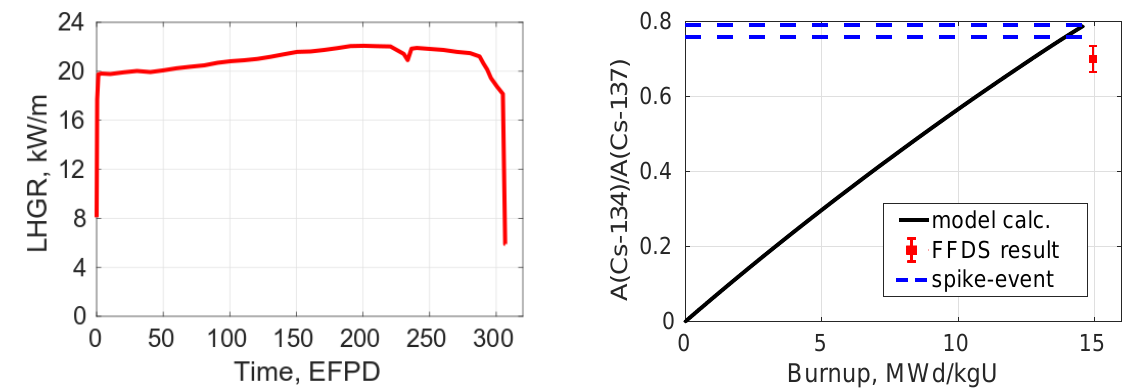
Figure 4. TVSA-12 #1, suspect rod: average LHGR and comparison of 134 Сs/ 137 Cs activity ratio